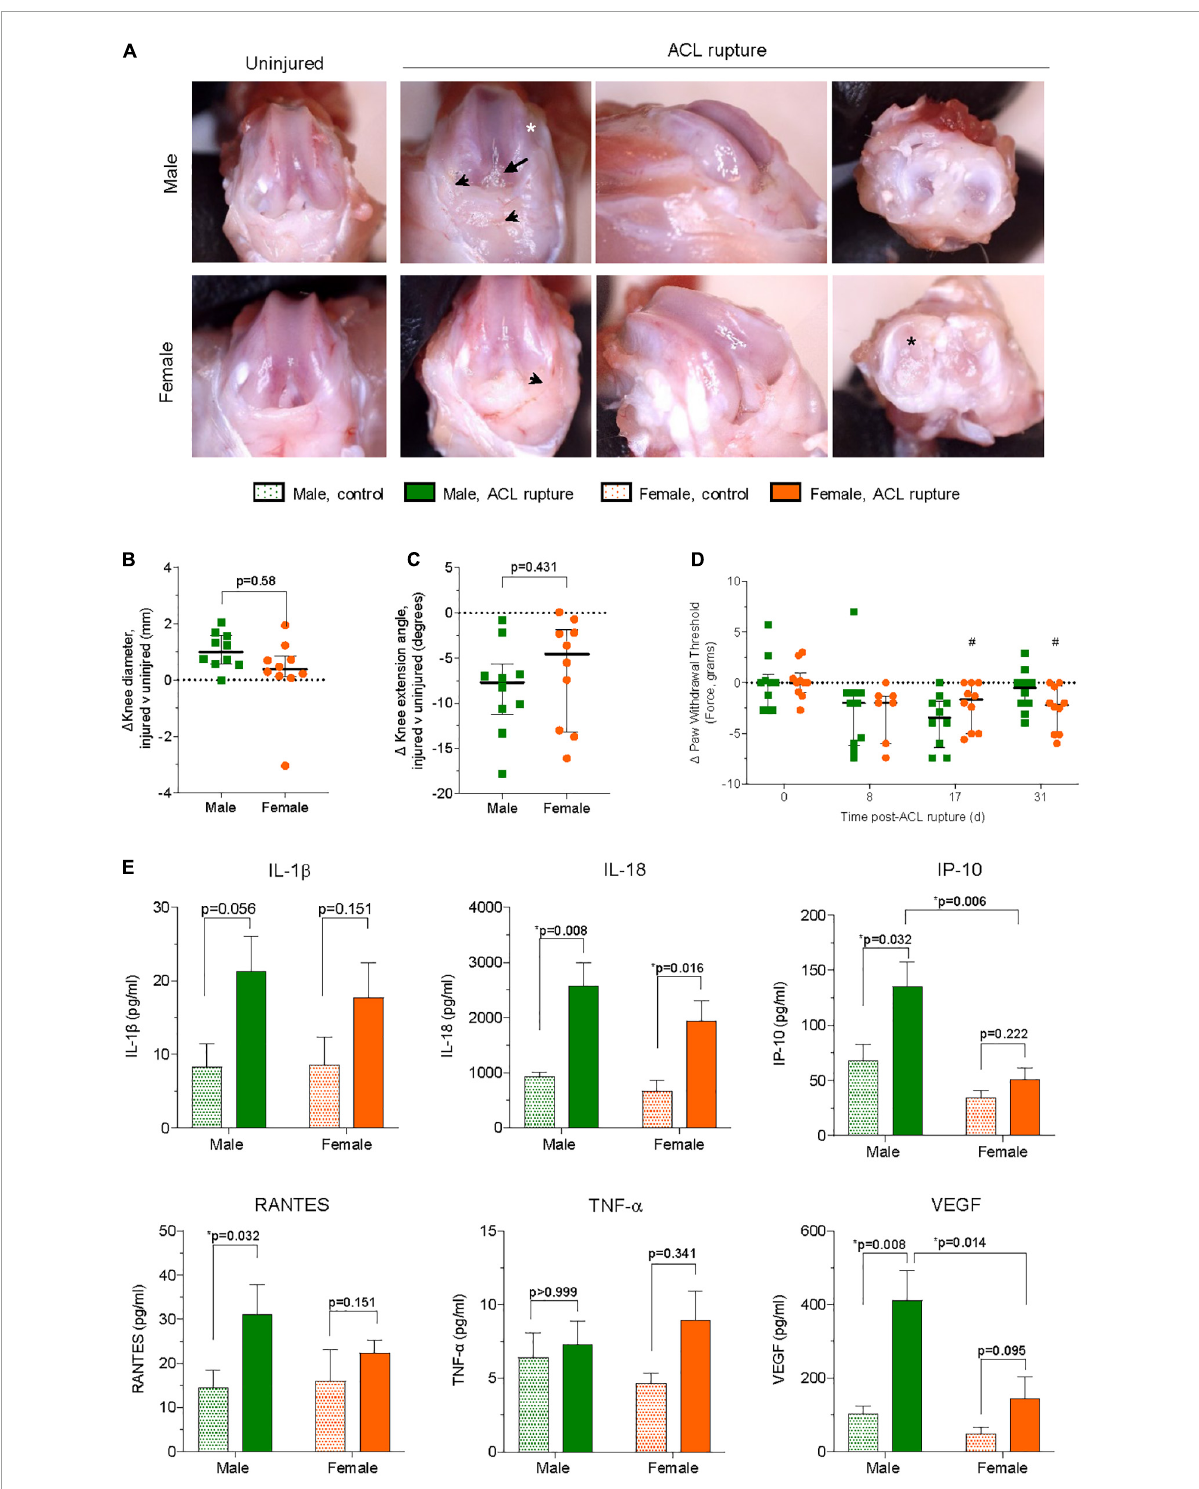
FIGURE3 (A) Representative images of macroscopic changes in ACL-ruptured knees of male and female animals at day 31 post-injury. Synovial and capsular hyperplasia (arrowhead), articular cartilage defects on medial femoral condyles (white asterisk) and medial meniscus (black asterisk), and outgrowth of synovial tissue around ACL remnants (arrow) were frequently observed. Differences in (B) knee diameter, (C) knee extension angle, and (D) pain behavior between ACL-ruptured and control knees of male and female animals. Data show median ± IQR. Mann-Whitney U -test, # p < 0.05 female, compared to baseline. (E) Synovial fluid concentrations of cytokines and chemokines in ACL-ruptured and control knees of male and female animals at day 31 post-injury. IL, interleukin; IP, interferon-inducible protein; RANTES, regulated upon activation, normal T cell expressed and presumably secreted; TNF, tumor necrosis factor; VEGF, vascular endothelial growth factor. Data show mean ± SEM. Two-way ANOVA, Sidak’s multiple comparisons test, * p <